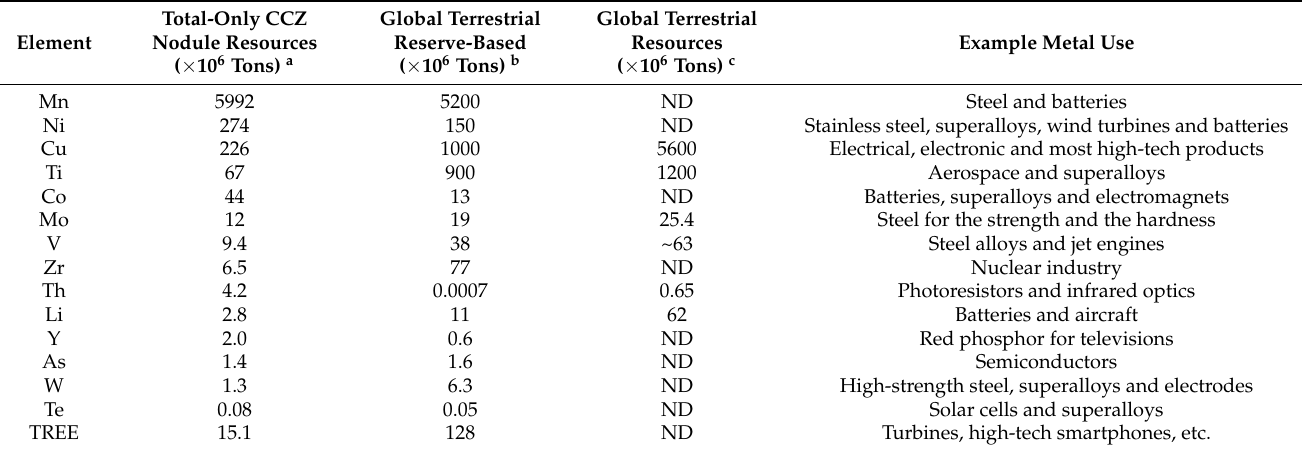
Table 1. Global tonnages of metals in the Clarion Clipperton Zone (CCZ) polymetallic nodules versus terrestrial deposits (from